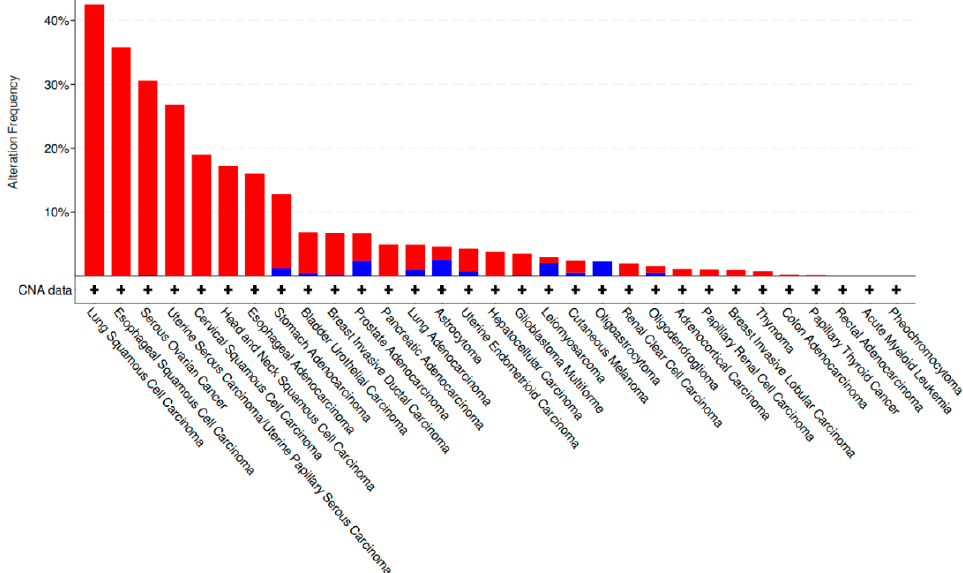
Figure 2. Amplification (red)/deletion (blue) frequency of the 3q amplicon kinase genes PIK3CA , PRKCI , MAP3K13, TNIK , and PAK2 in a The Cancer Genome Atlas (TCGA) pan-cancer analysis using cBioPortal. A minimum cutoff of 85 clinical samples was used per cancer type.